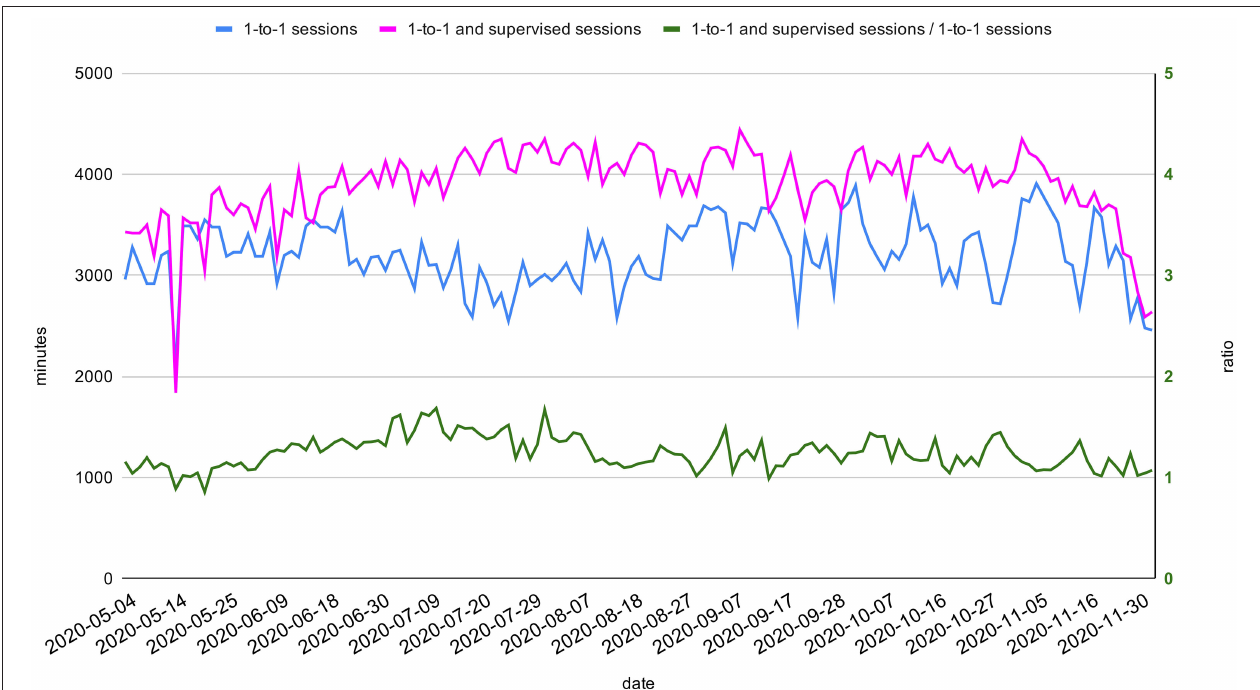
FIGURE 5 | Total daily minutes of therapy sessions. Total daily minutes of one-to-one and minutes of all sessions (both one-to-one and supervised) between May 2020 and November 2020 (light blue and dark blue on the left axis). The ratio between the two aforementioned quantities (pink) is represented on the right axis.